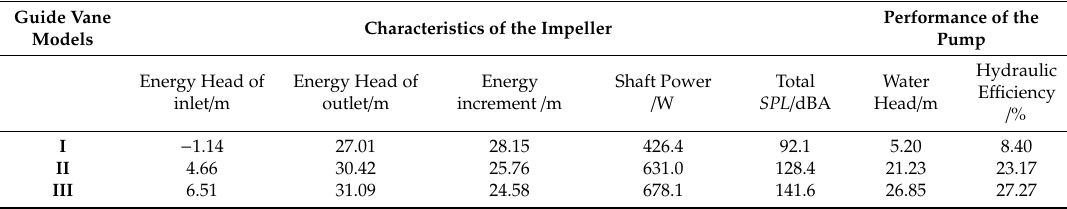
Table 5. The influence of guide vanes on the hydraulic and hydroacoustic characteristics of the impeller. Guide Vane Models